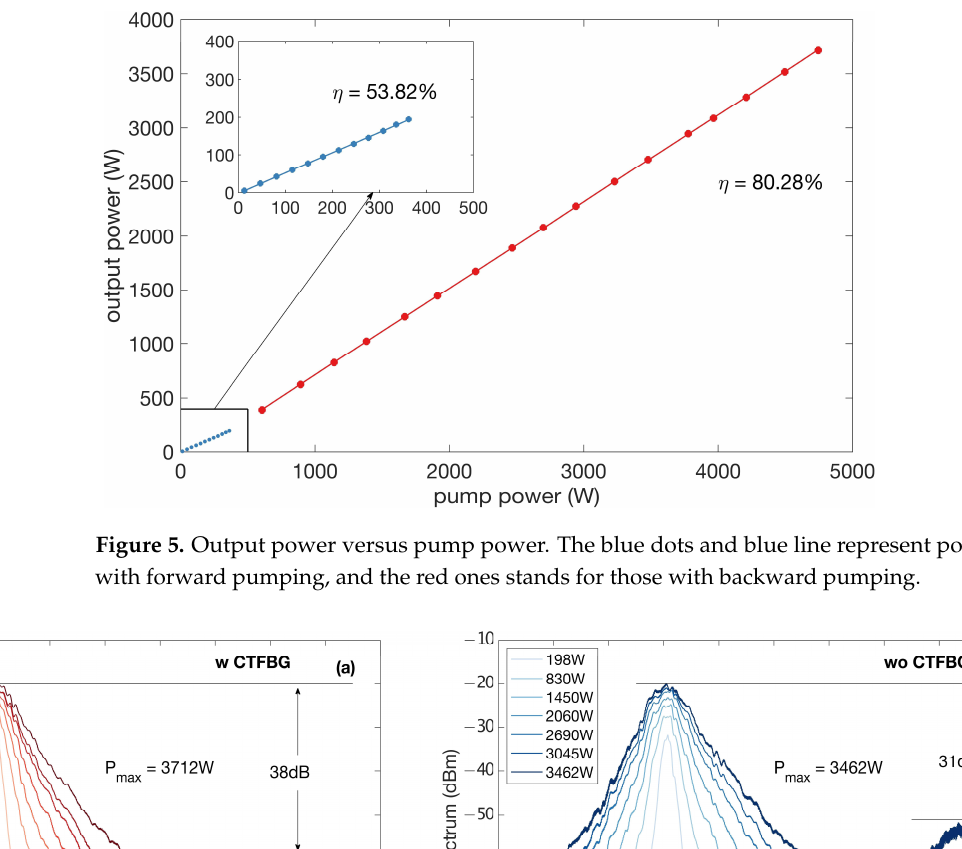
Figure 4. Picture of the oval-shaped aluminum cylinder acting as the heat sink.